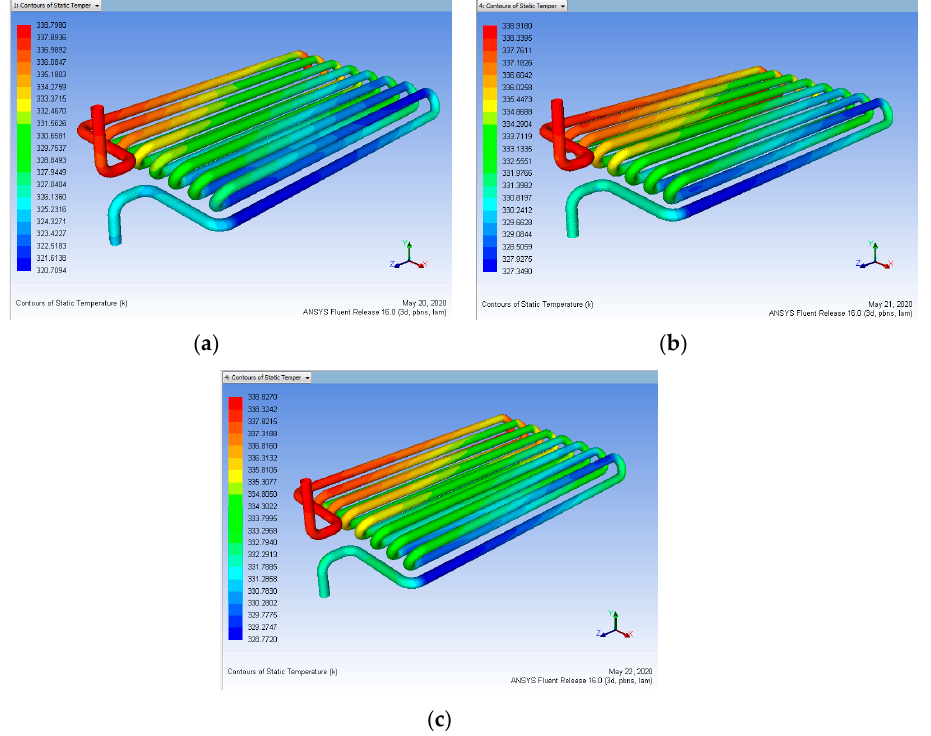
Figure 18. Heat input 343 K vs. Coating Thickness 80 µ m for mass flow rate ( a ) 0.15, ( b ) 0.30, ( c ) 0.45 L / min (After